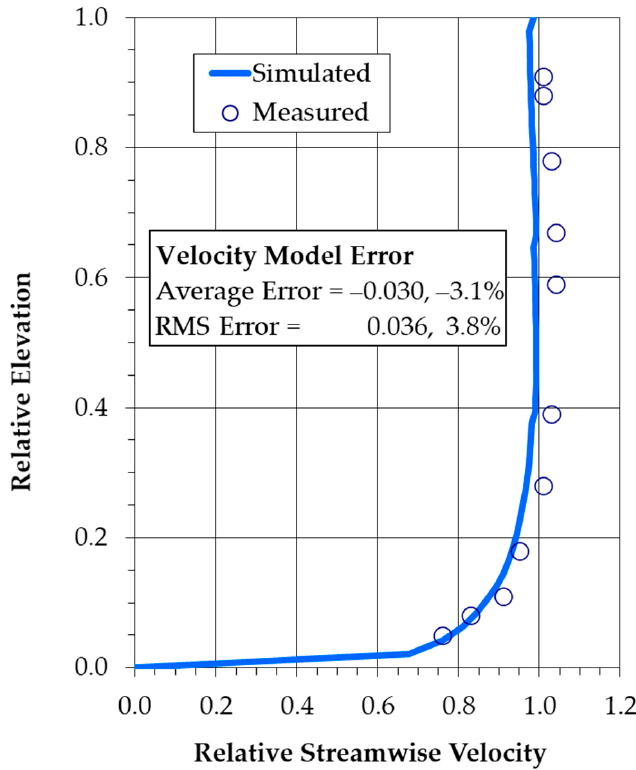
Figure 11. Comparison of simulated and measured velocity profile at cross-section S0 at position 0.00 B.